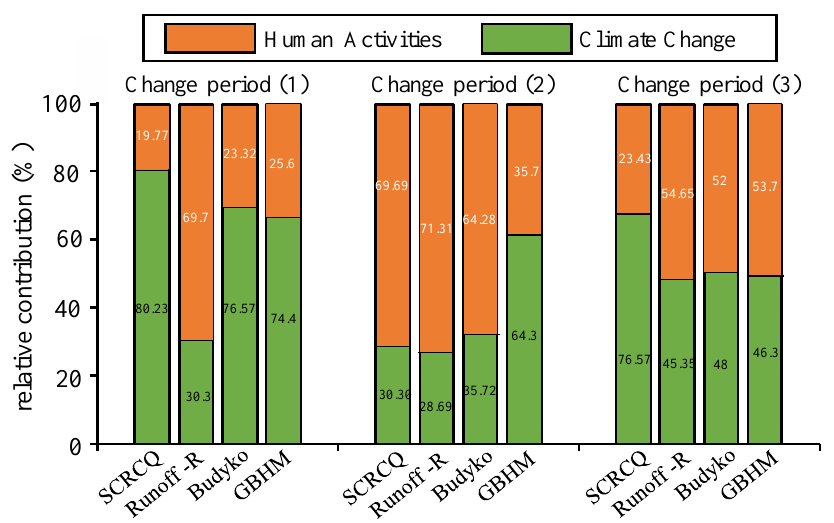
Figure 10. Comparison of the relative contributions of climate change and human activities to decreases in runoff calculated by the four methods. (SCRCQ = slope change rate cumulative quantity; Runoff-R = the runoff reduction method).